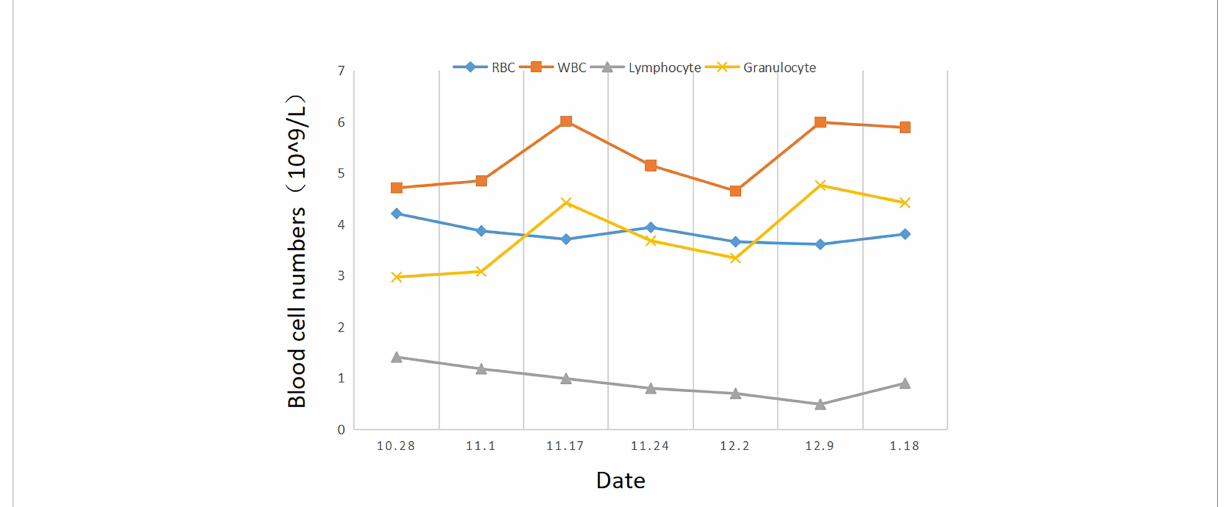
FIGURE 2 The changes in complete blood count (RBC, WBC, lymphocyte, and granulocyte) depended on the date (October 28, 2021-January 18,